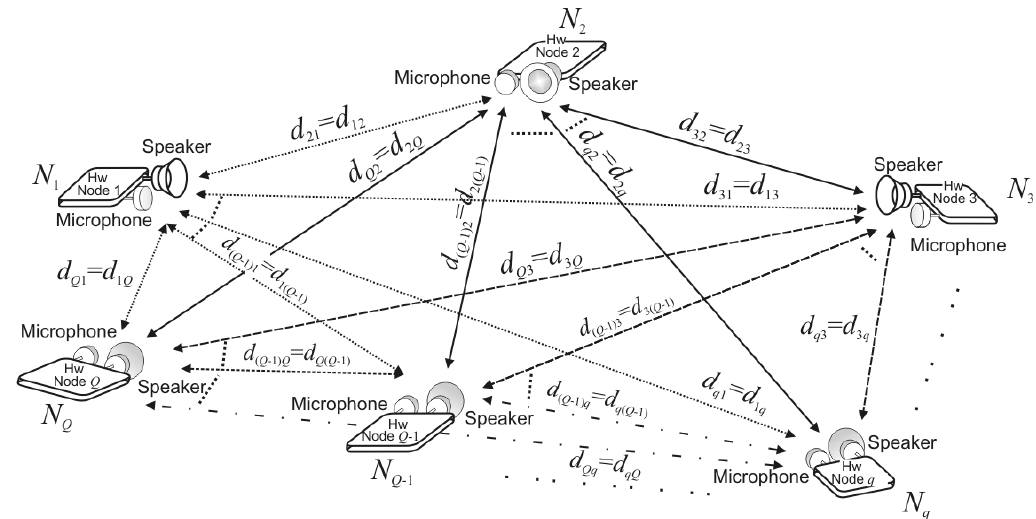
Figure 1. General scheme of the proposed sensor